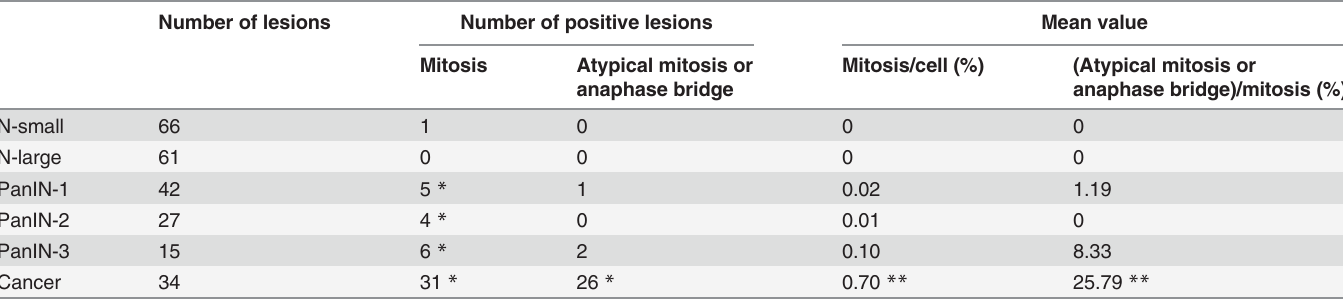
Table 1. Mitosis and anaphase bridges in pancreatic tissues.